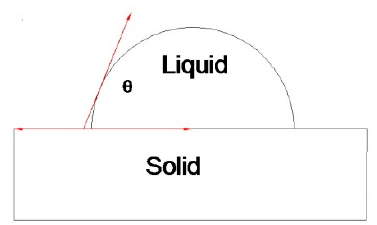
Figure 5. Schematic diagram of contact angle.